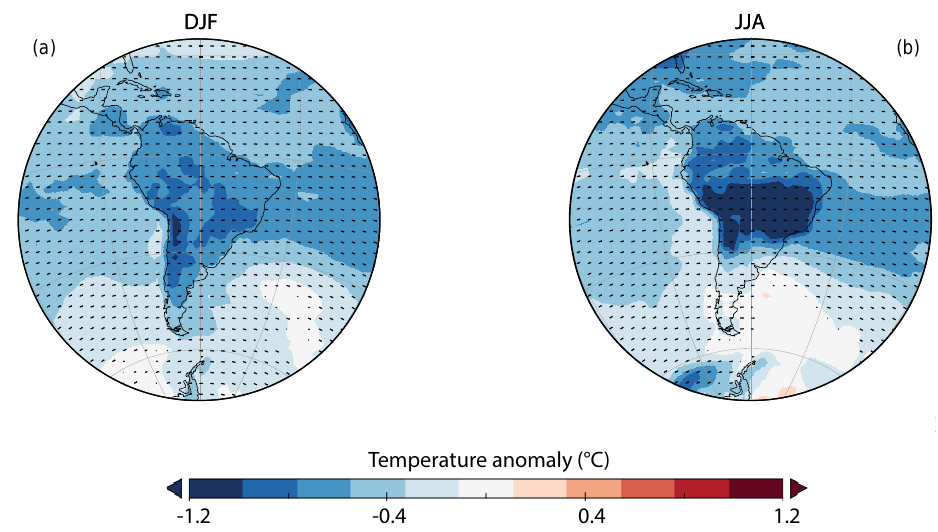
Figure 7. Last millennium post-volcanic temperature composite ( ◦ C) averaged over all 45 events during (a) DJF and (b) JJA from GISS ModelE2-R using procedure described in the text. Stippling highlights areas with anomalies significant at p< 0 .